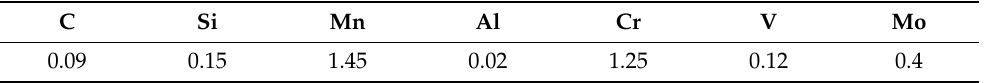
Table 1. Average chemical composition of the steel expressed in wt% according to manufac- turer datasheets. C Si Mn Al Cr